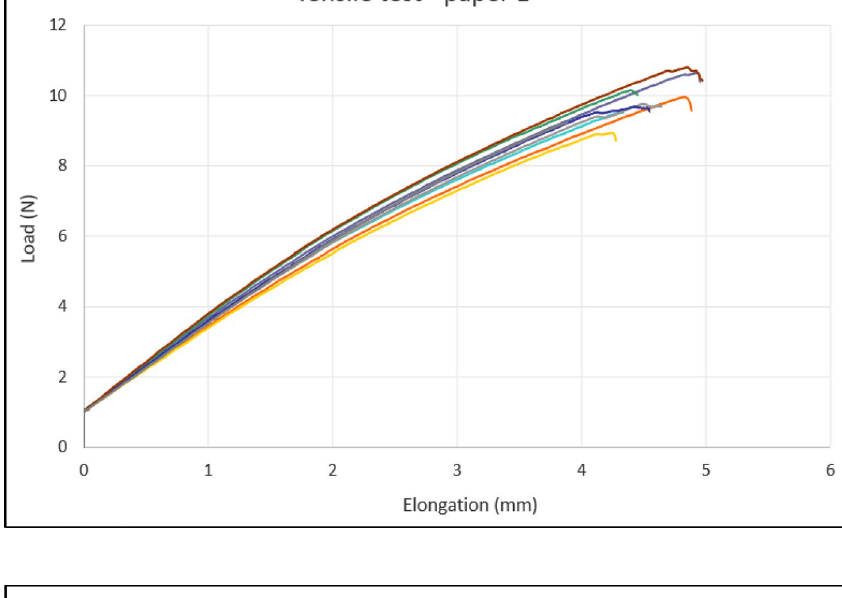
Fig. 37 Force elongation curves of individual specimen of paper